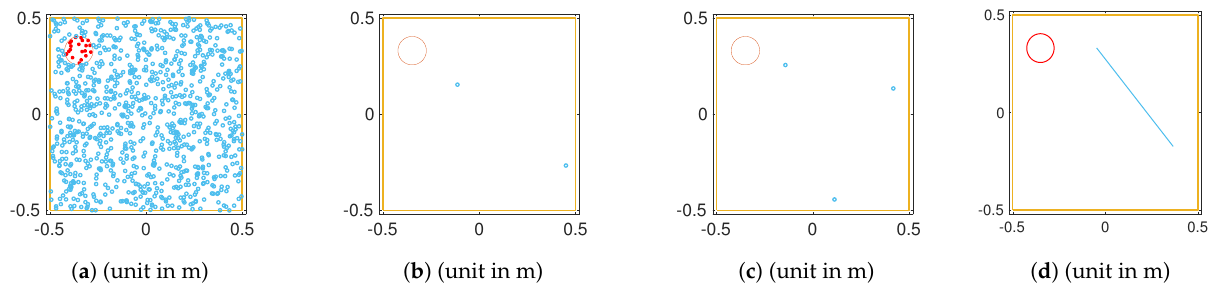
Figure 3. ( a ) 1-point probability function: the red points are inside the voids, and the blue points are outside of voids, the fraction of red points (void space) to the sum of red and blue points (total volume) called 1-point probability function, ( b ) 2-point probability function: two points are randomly tossed, and the event when all 2 points fall outside voids is considered, ( c ) 3-point probability function: three points are randomly tossed in microstructures, and the event when 3 points fall outside voids is considered, ( d ) lineal-path probability function: the probability when the whole line is positioned inside voids. Table 1. Minimum, maximum, and average of 4 probabilistic descriptors for 100